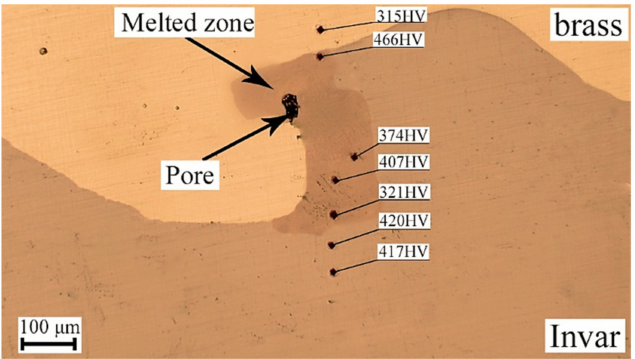
Figure 8. Measurement of microhardness in the melted zone and its vicinity.